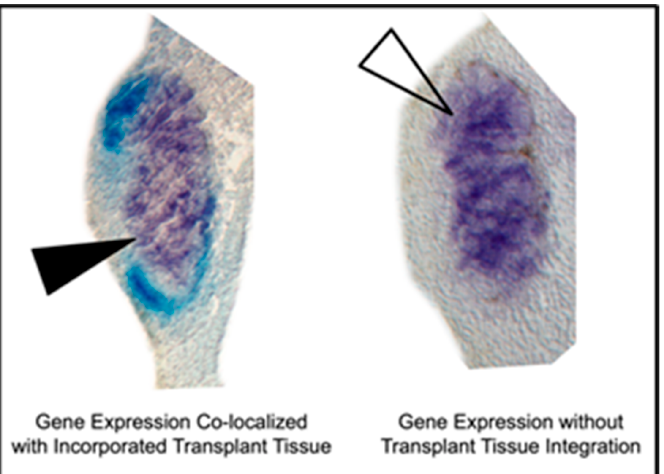
Figure 3. Images showing criteria for discerning between co-localization of gene expression with integrated transplant tissue and endogenous expression. Light blue coloring indicates transplanted tissue and purple coloring indicates Otx2 expression via in situ hybridization. These specific examples are sections from the mid-gastrula sham surgery showing Otx2 expression ( left ) and the late gastrula sham surgery showing Otx2 expression ( right ).